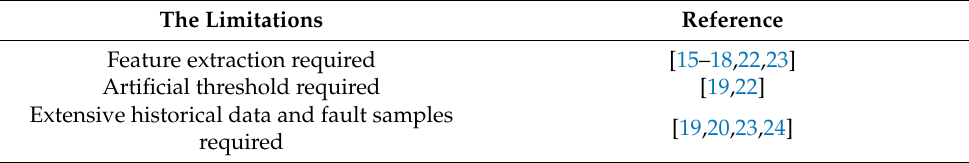
Table 1. The limitations in the existing radar malfunction prognosis